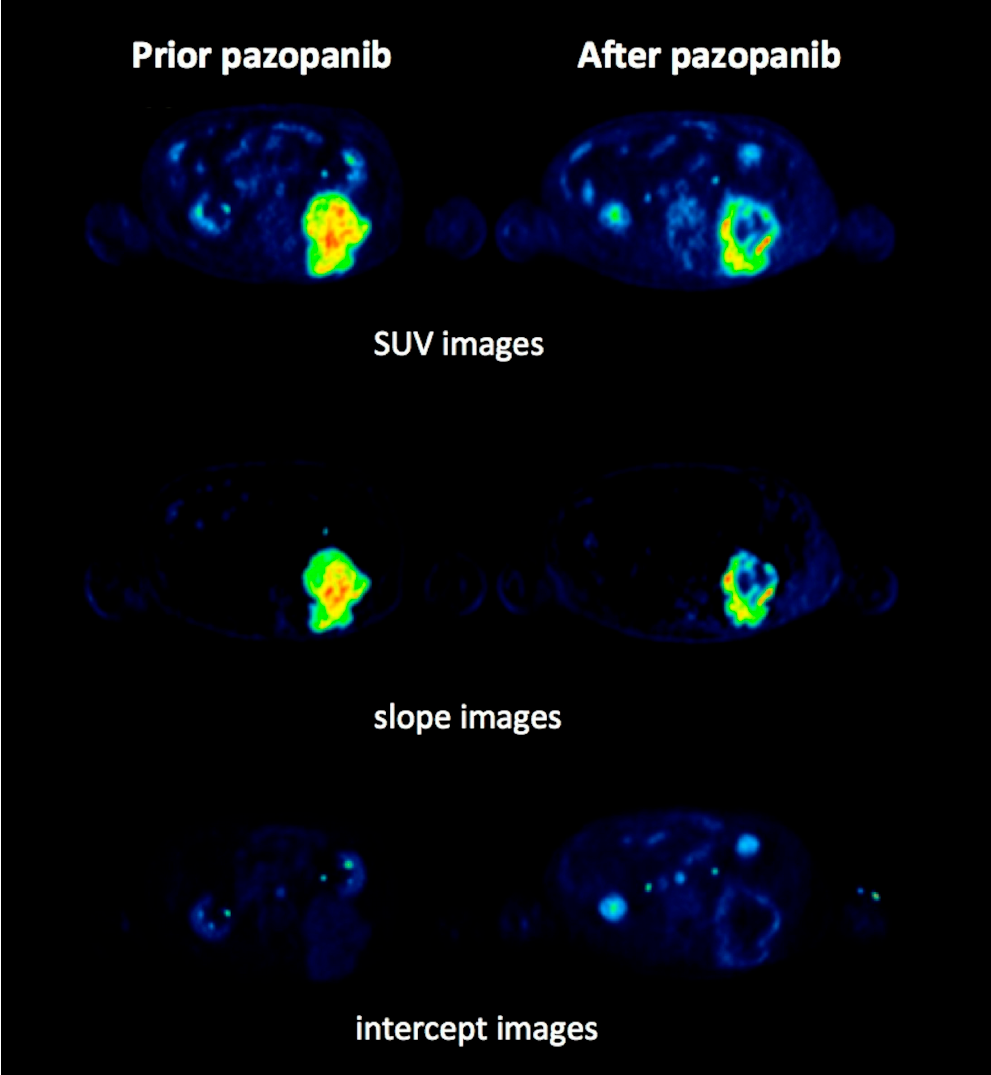
Figure 3. Transaxial fludeoxyglucose F-18 positron emission tomography / computed tomography ( 18 F-FDG PET / CT) of the same patient as in Figure 2 before (left) and after pazopanib therapy (right). Standardized uptake value (SUV) images acquired after 60 min of dynamic PET acquisition show a clear metabolic remission of the intense metabolic lesion with central necrosis in response to pazopanib (upper row). Slope parametric images also show initially intense uptake in the area of the tumor, which responds with an essential decrease after therapy due to a decrease in the phosphorylation (middle row). Intercept parametric images demonstrate the tumor very faintly due to the low distribution volume (lower row).